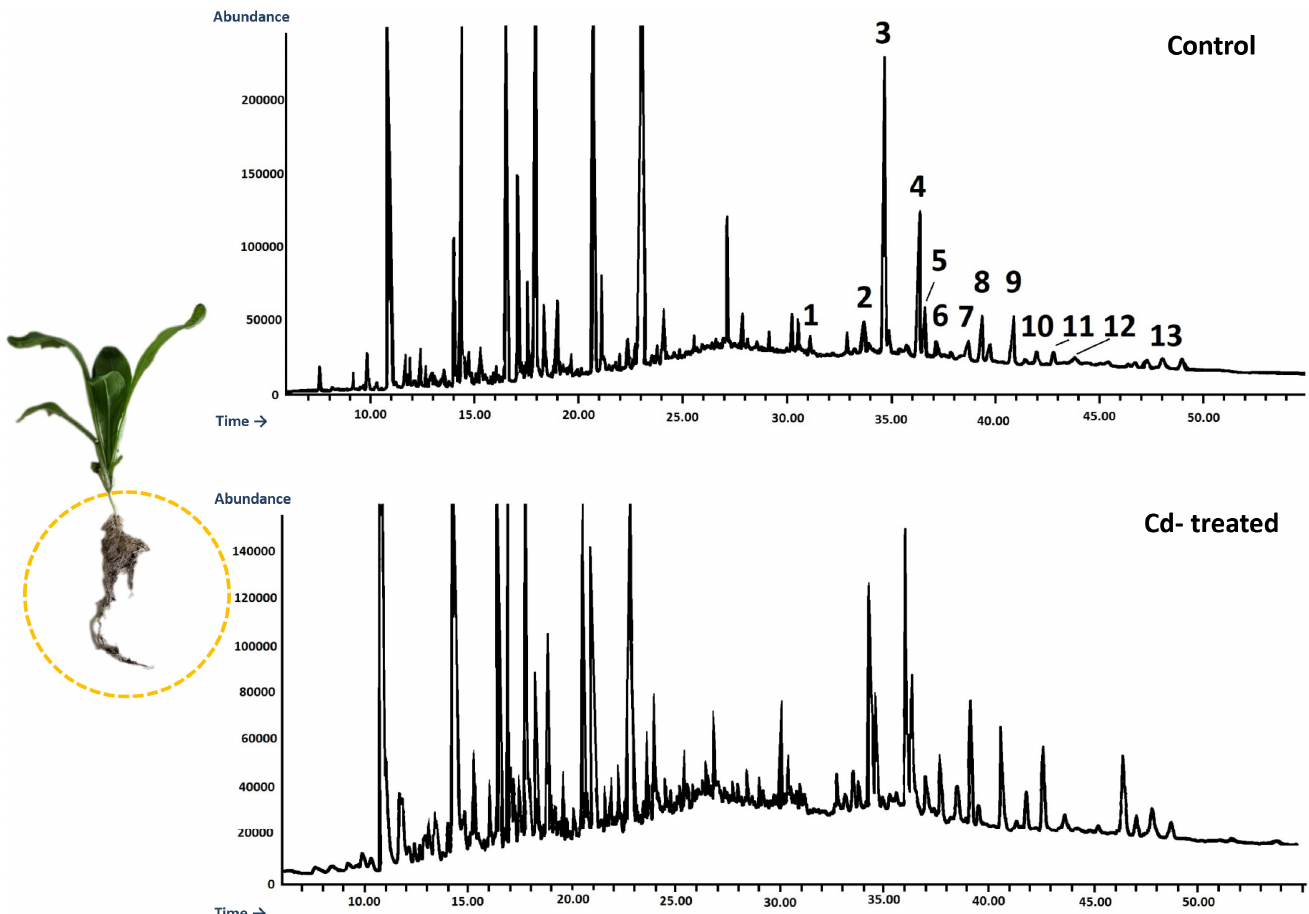
Figure 16. Representative chromatograms of the fractions containing free steroids from diethyl ether extracts obtained from control and cadmium-treated roots of marigold plants after 14 days of cultivation: 1, cholesterol; 2, campesterol; 3, stigmasterol; 4, sitosterol; 5, sitostanol; 6, β -amyrin; 7, α -amyrin; 8, tremulone; 9, sitostenone; 10, cycloartenol acetate; 11, friedelinol; 12, friedelin; 13, stig- mastane-3,6-dione.